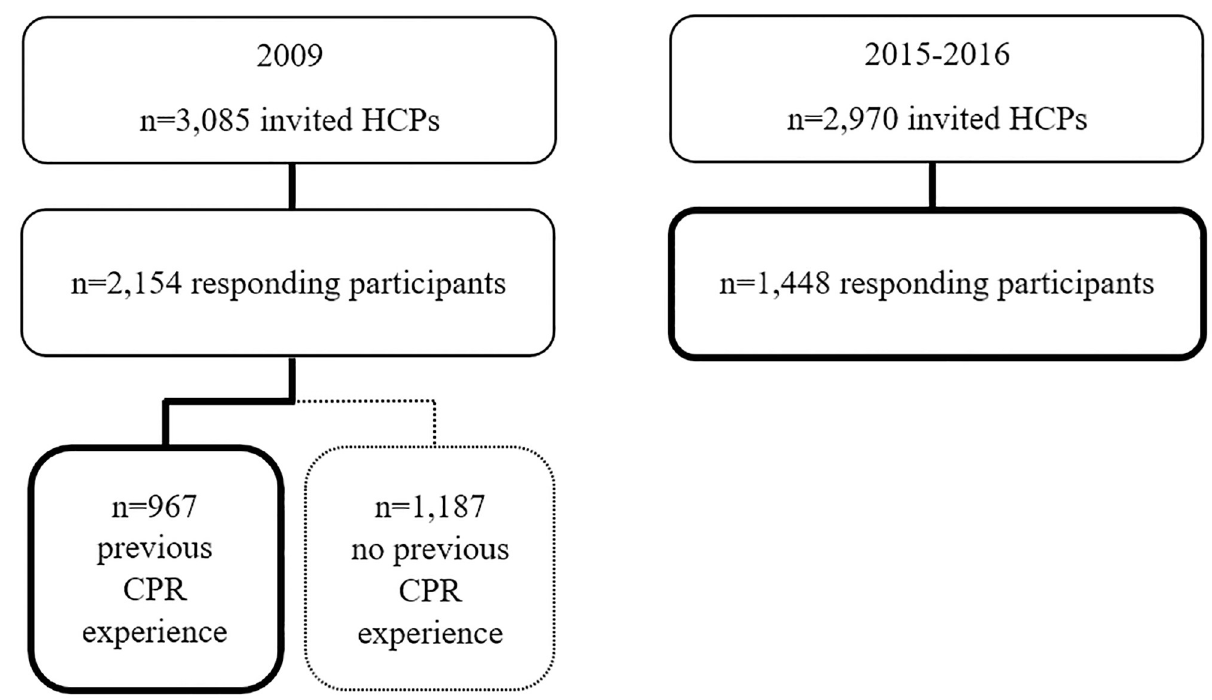
Fig 1. Flowchart of